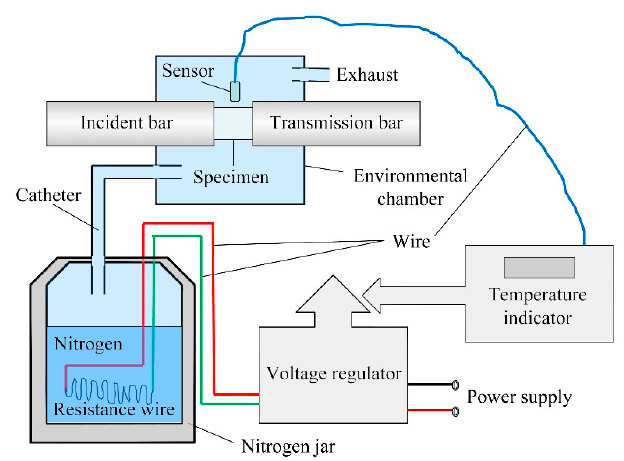
Figure 11. Principle diagram of low-temperature control system.